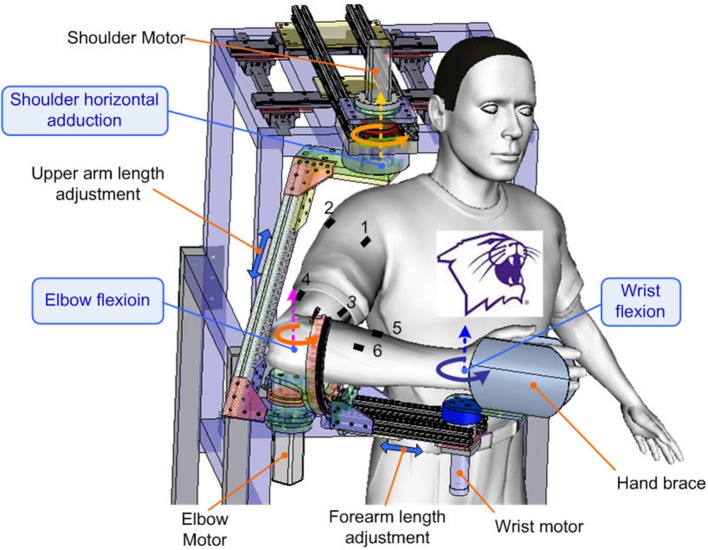
Experimental setup with the subject performing self-paced multi-joint movements with the upper limb exoskeleton robot. The dashed—line arrows mark the axis shoulder horizontal adduction-abduction, elbow flexion-extension, and wrist flexion-extension axes. The double—headed arrows indicate the arm adjustment of the robot. The other degrees of freedom of the robot have been omitted from the figure for clarity. EMG electrodes 1 to 6 were used to record muscle EMGs from the anterior deltoid, posterior deltoid, biceps brachii, triceps long head, flexor carpi radialis, and extensor carpi radialis muscles of the dominant arm of the subject, respectively.